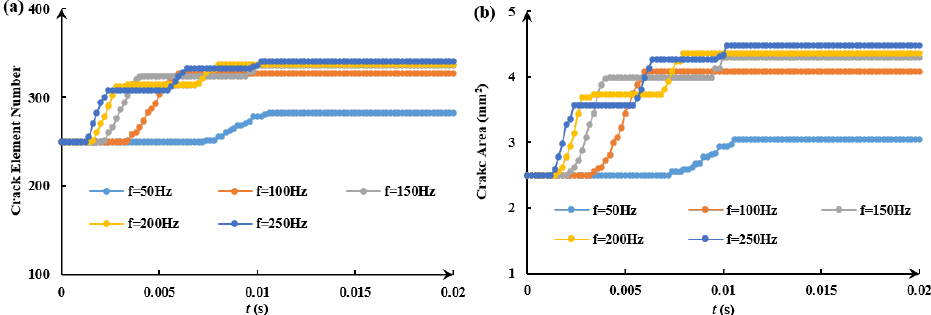
Figure 12. Fracture degree of the crack under different frequencies of dynamic load: ( a ) crack element number; ( b ) crack area.